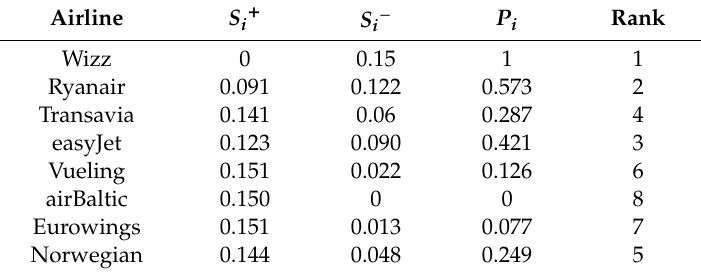
Table 3. Results of TOPSIS LCCcriteria. Source: compiled by the authors.